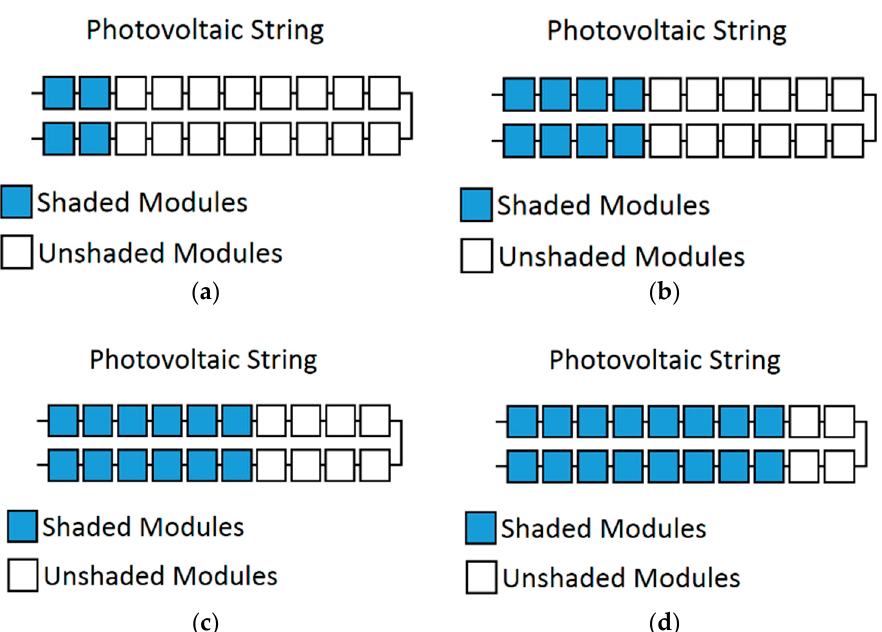
Figure 5. Experiment setups: ( a ) Four modules shaded setup; ( b ) eight modules shaded setup; ( c ) 12 modules shaded setup; ( d ) 16 modules shaded setup.